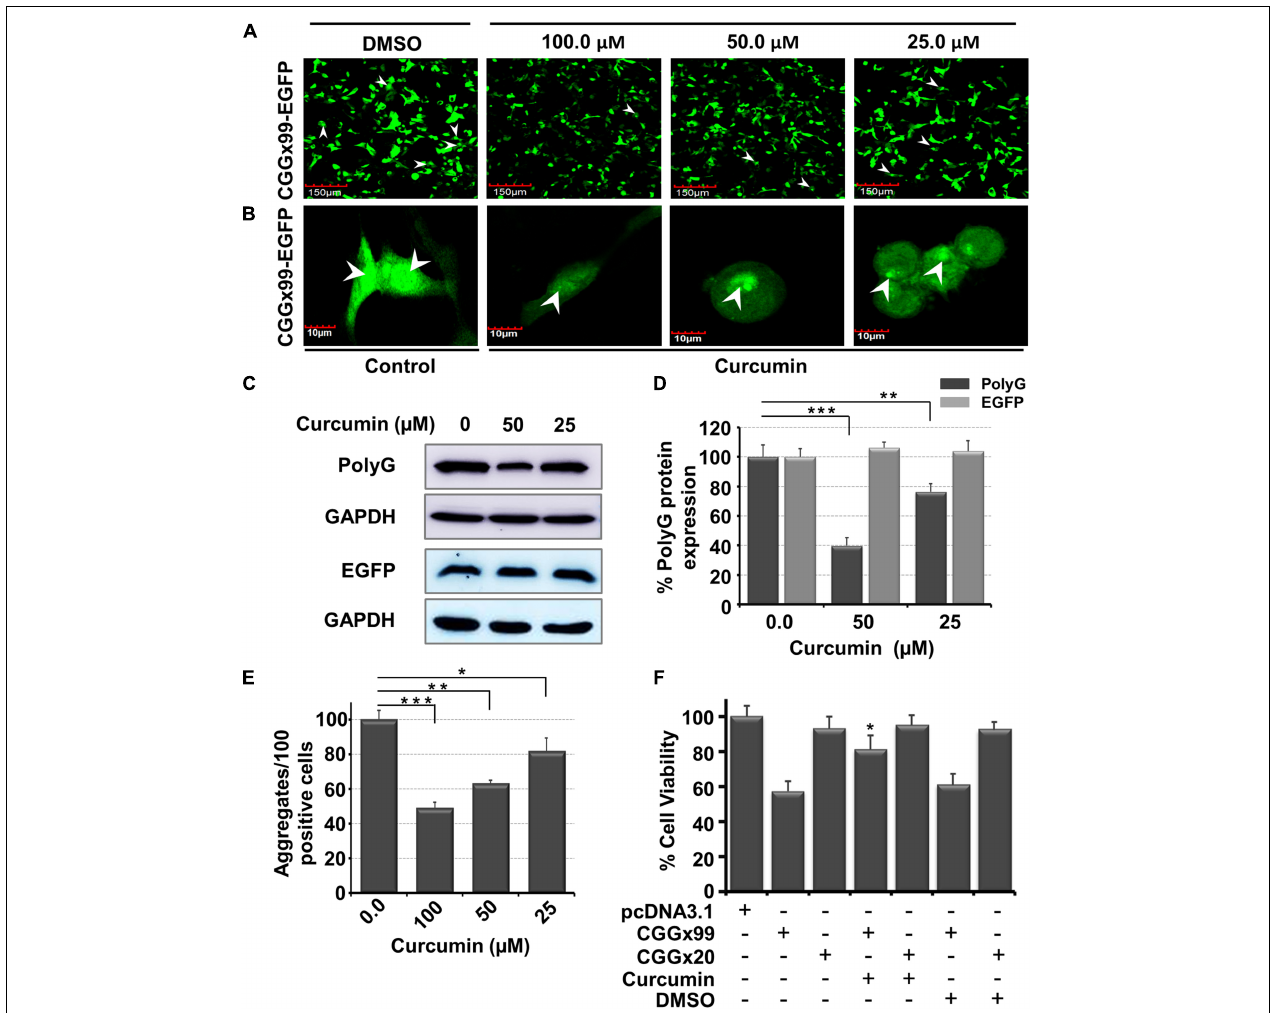
FIGURE 7 | Diagram shows in vitro potency of Curcumin in FXTAS cultured cell models. In FXTAS, CGG expansion triggers the non-canonical protein translation leading to protein aggregate formation inside the cell. (A,B) Micrograph showing the effect of Curcumin treatment in transiently transfected [(CGGx99)-EGFP] HEK cell. (A) 20 × image and (B) 60 × image of DMSO (control) and Curcumin for 24 h. (C) Blot showing the reduction of polyG aggregates formation as a function of Curcumin concentration with control GAPDH and EGFP plasmid (lacking CGG repeat). (D) Bar graph showing the percentage reduction of polyG aggregate in presence of Curcumin. (E) Plot denotes Curcumin treatment reduces number of protein aggregates in the cell. (F) Bar graph showing improvement of cell viability of transfected HEK cells with plasmid CGGx20, CGGx99 and EGFP in presence of Curcumin. Standard deviation represented by Error bars. One-way ANOVA was used for determination of statistical significance except cell viability enhancement (F) assay where student t -test were utilized. *** p < 0.001; ** p < 0.01; * p <